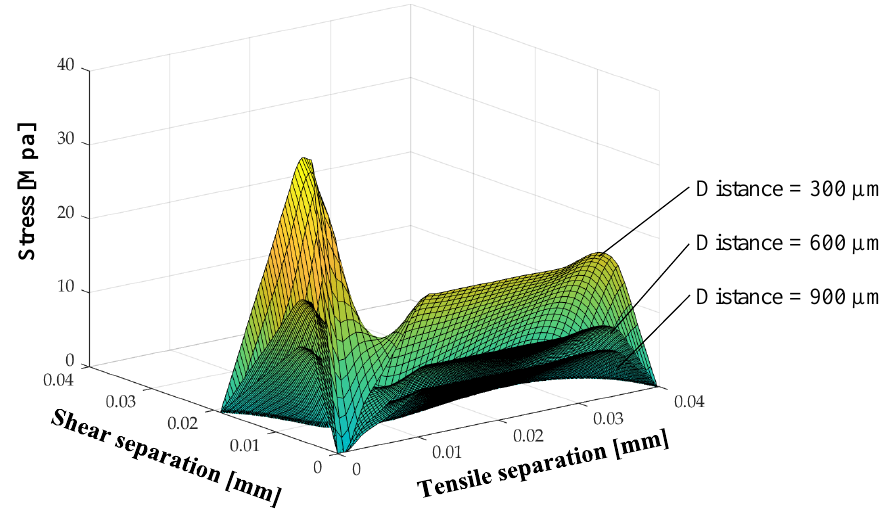
Figure 14. 3D illustration of the cohesive-zone models for different distances.